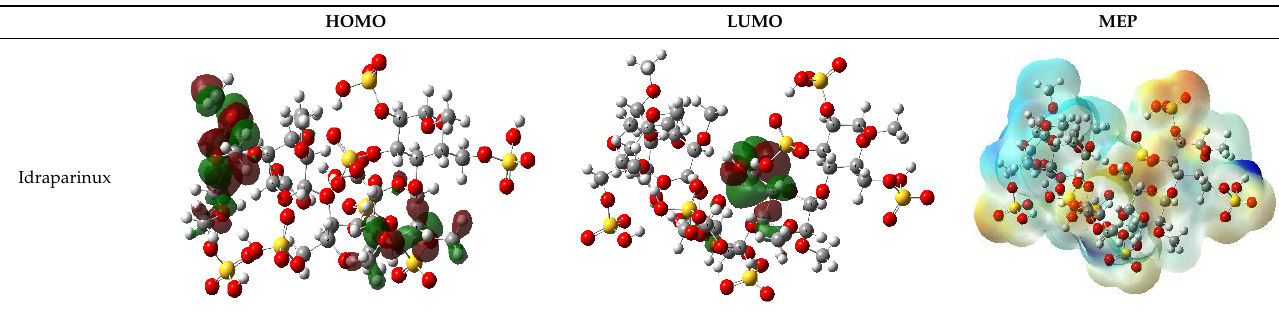
Table 4. Charge densities of outermost orbitals and MEP map of the most promising compounds optimized at the B3LYP/6-311G* level of theory.